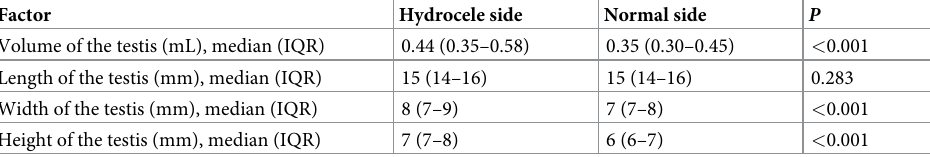
Table 1. Comparison of the testes’ parameters on the hydrocele and normal sides in 138 patients. Factor Hydrocele side Normal side P Volume of the testis (mL), median (IQR) 0.44 (0.35–0.58) 0.35 (0.30–0.45) < 0.001 Length of the testis (mm), median (IQR) 15 (14–16) 15 (14–16) 0.283 Width of the testis (mm), median (IQR) 8 (7–9) 7 (7–8) < 0.001 Height of the testis (mm), median (IQR) 7 (7–8) 6 (6–7) < 0.001 IQR, interquartile